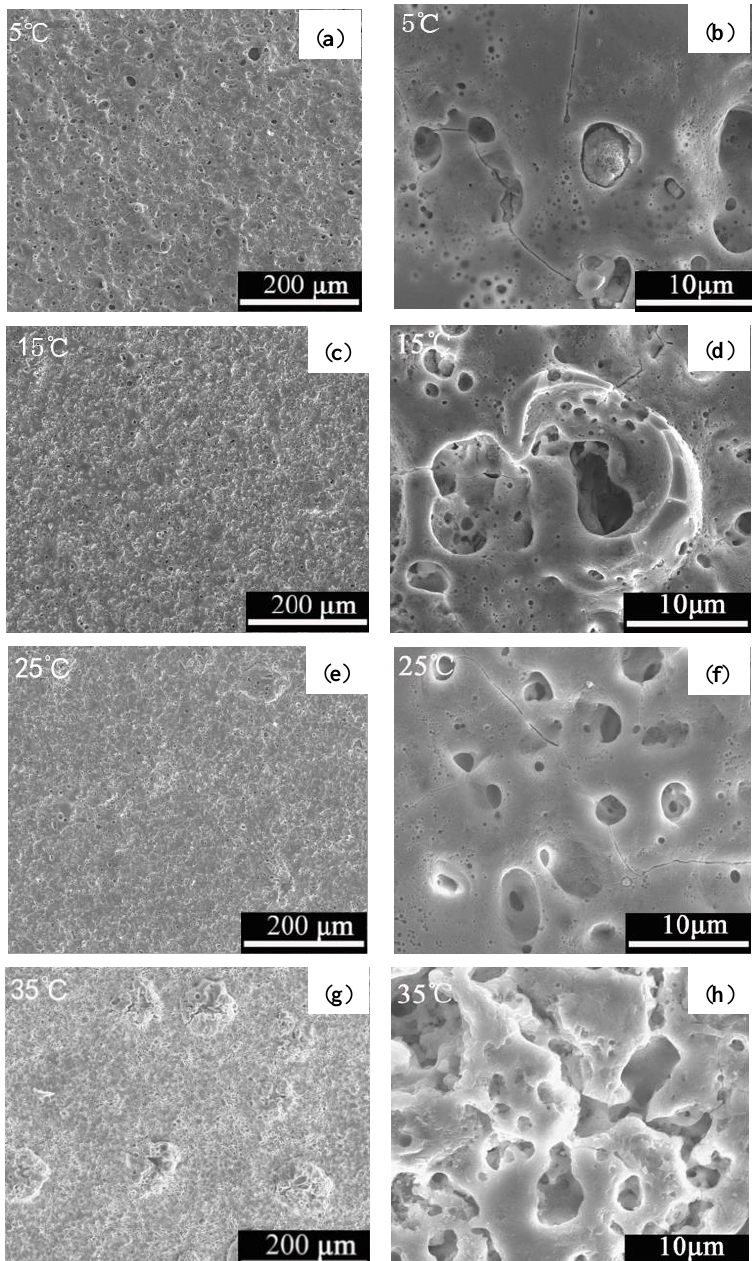
Figure 5. Morphologies of PEO coatings prepared at different electrolyte temperatures (500×: ( a , c , e , g ); 10,000×: ( b , d , f , h )).